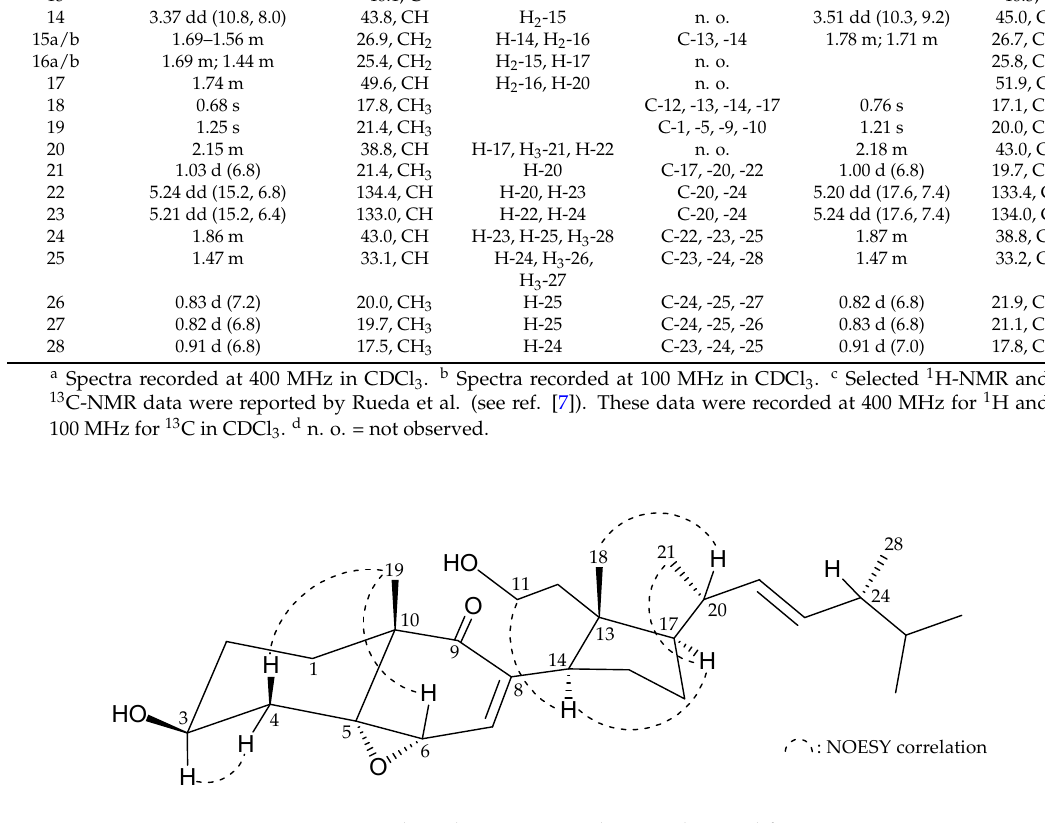
Figure 2. Selected NOESY correlations observed for 1 .